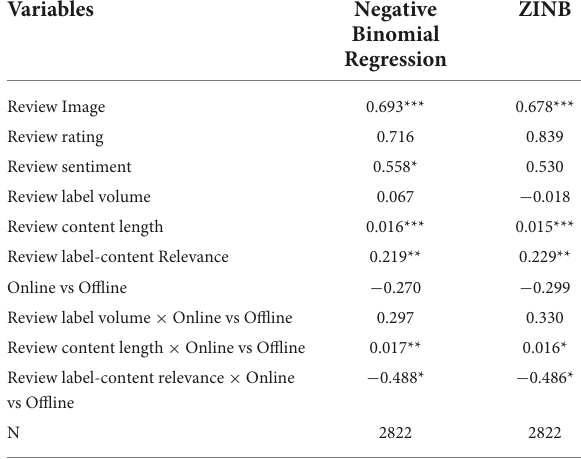
TABLE 4 Robustness check results for alternative model